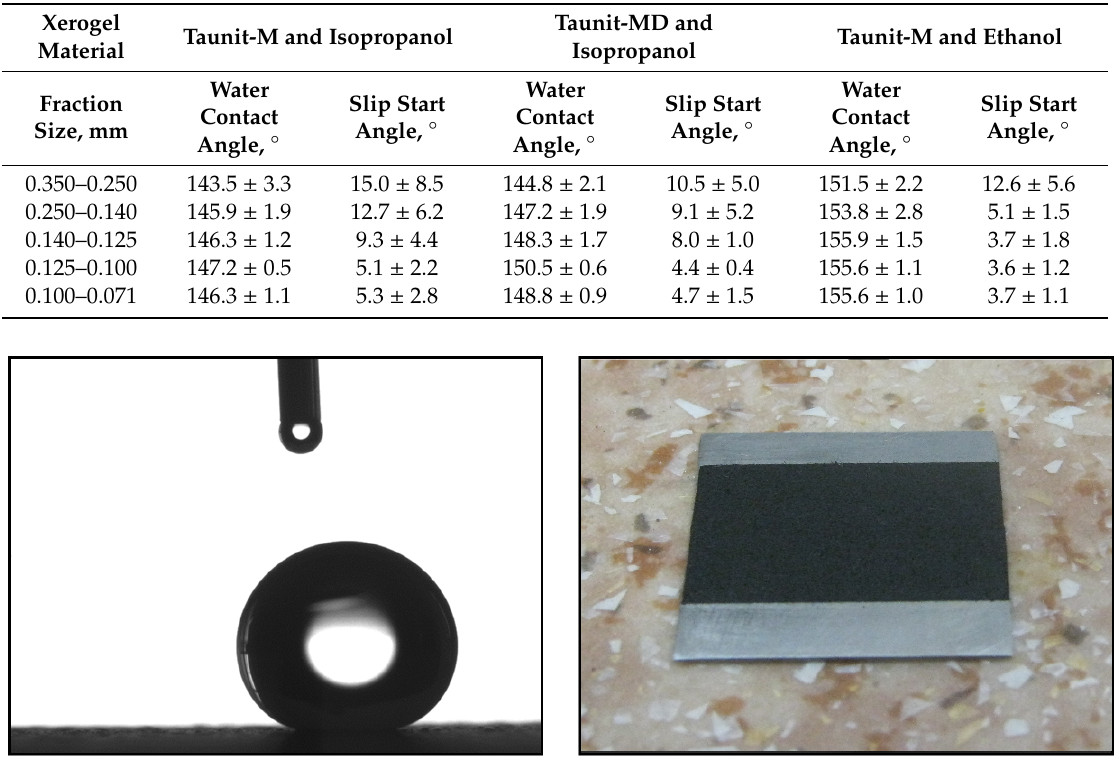
Figure 4. On the left is the image of drop on the best sample (water contact angle 159 degrees), on the right is the xerogel applied on the metal plate.